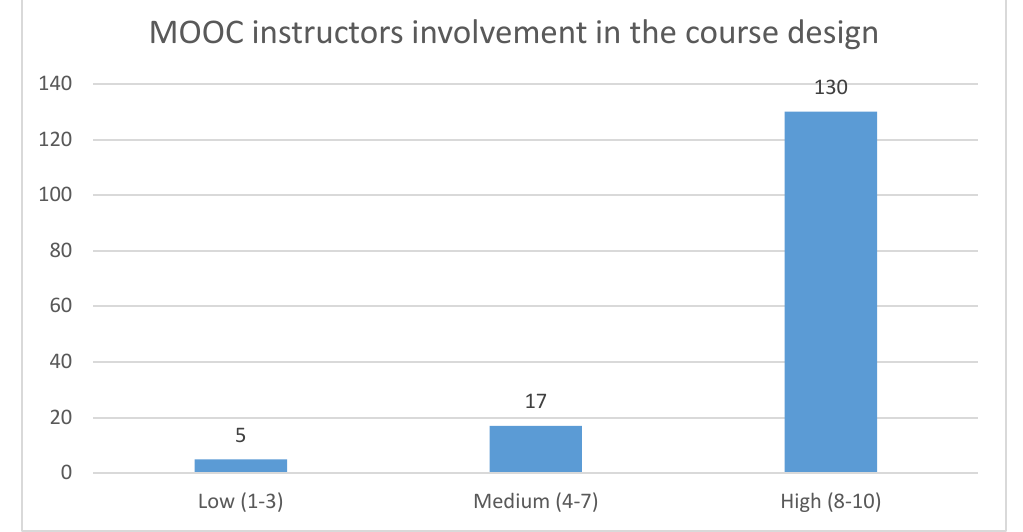
Figure 2 . MOOC instructor involvement in designing course content for the MOOC. Note: on a scale of 1 (low) to 10 (high)